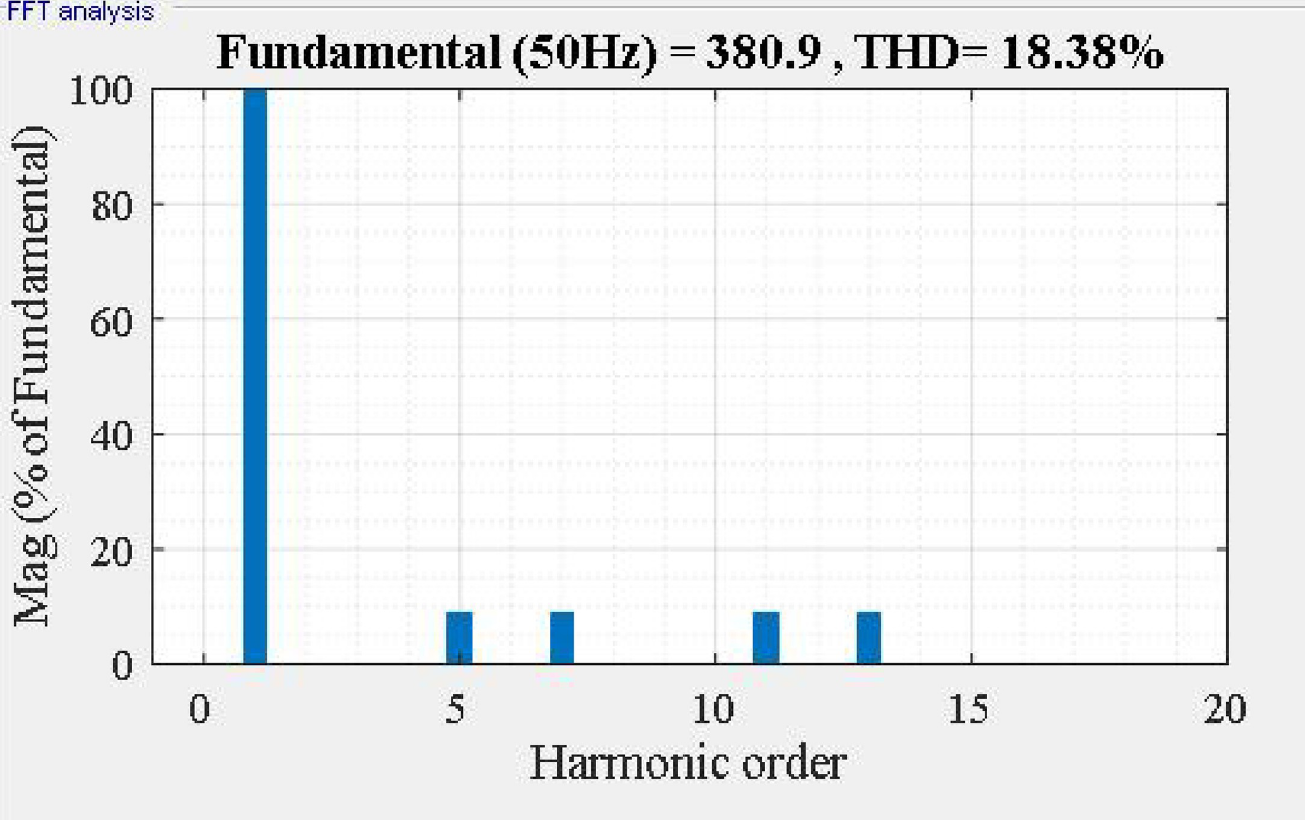
Fig 5. Frequency spectrum of i